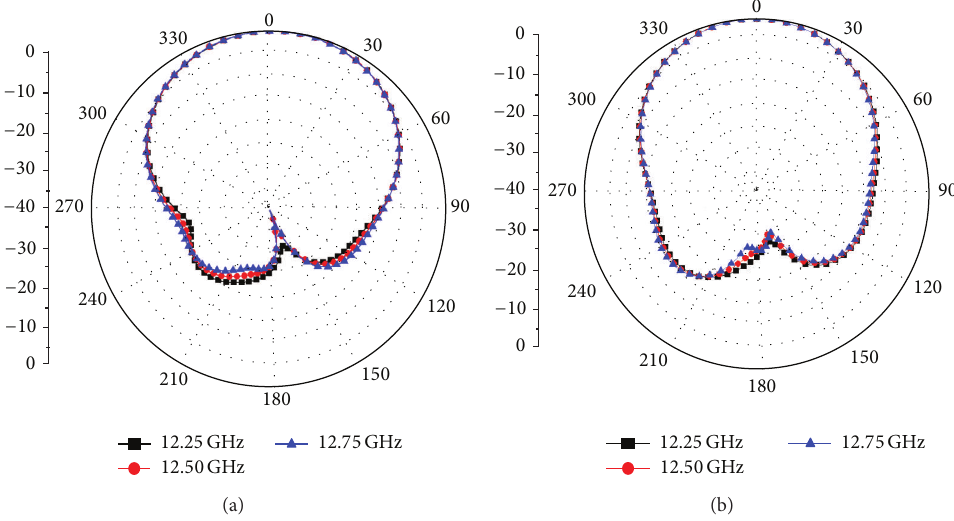
Figure 9: The normalized farfield patterns of the element at (a) E plane and (b) H plane.